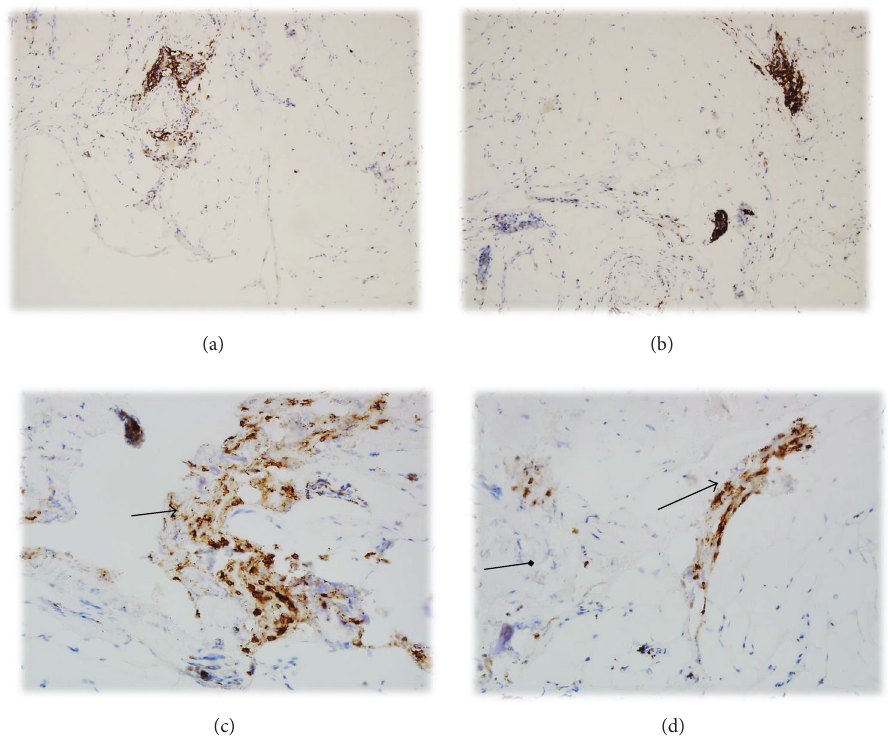
Figure 2: ((a), (b)) CD3 expression in T cells within the mild Graves ophthalmopathy. Magnification: 100x. ((c), (d)) CD3 strong expression in T cells within the severe Graves ophthalmopathy. Magnification: 200x (the arrows show T cells and fibroblasts).